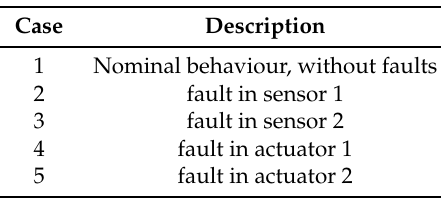
Table 3. Cases considered.